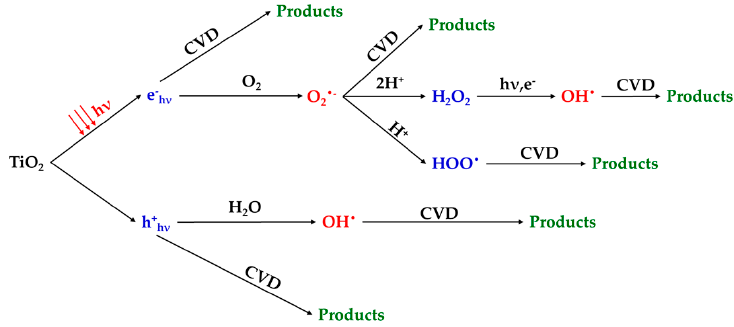
Figure 14. Degradation mechanism of crystal violet under TiO 2 + Clays + UV.